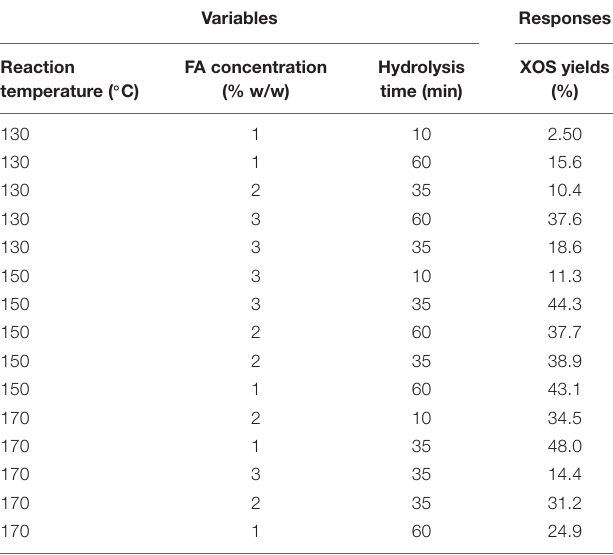
TABLE 1 | Different combinations of independent variables of software design and experimental results. Variables